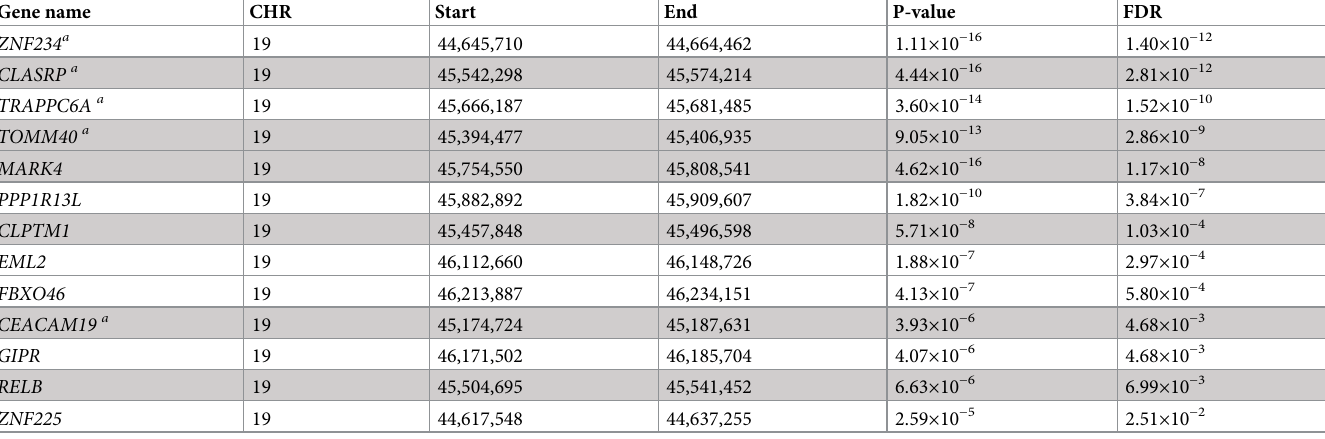
Table 2. Significant genes for phenotype AD clinical diagnosis by meta VC-TWAS with filtered DPR weights. Significant genes have FDR < 0.05 by meta-TWAS with ROS/MAP and Mayo Clinic cohorts. AD risk genes identified by previous GWAS are shaded in